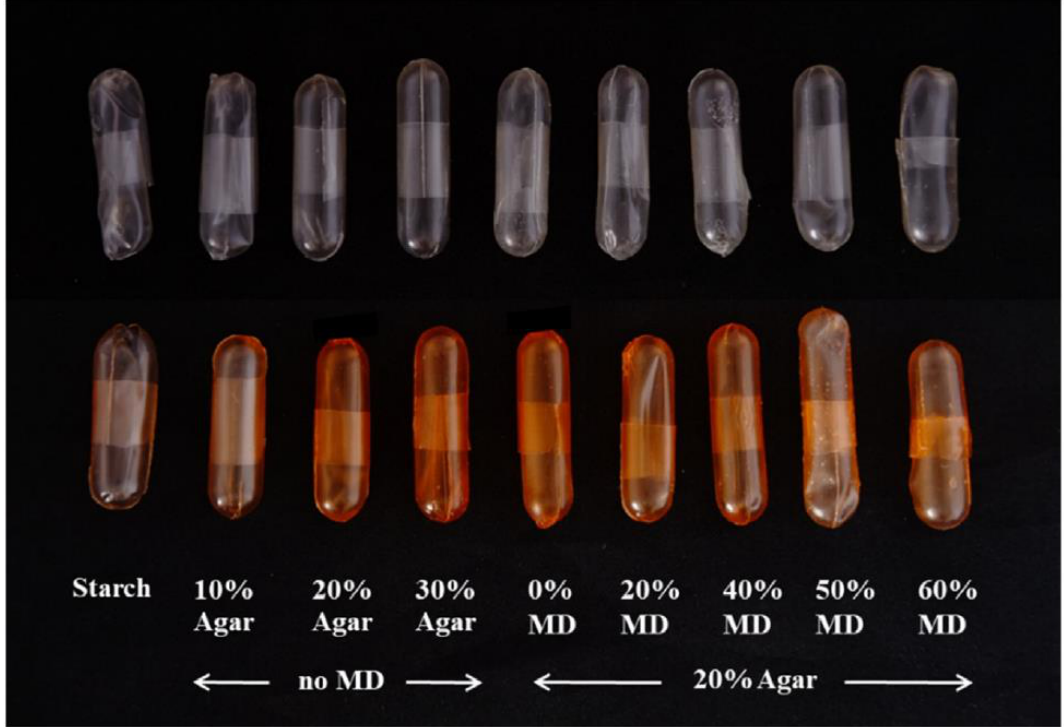
Figure 5. The appearance of capsules prepared by mold dipping with various ratios between starch, agar, and maltodextrin (MD). Reproduced with permission from [23]. (Copyright 2020 Elsevier).